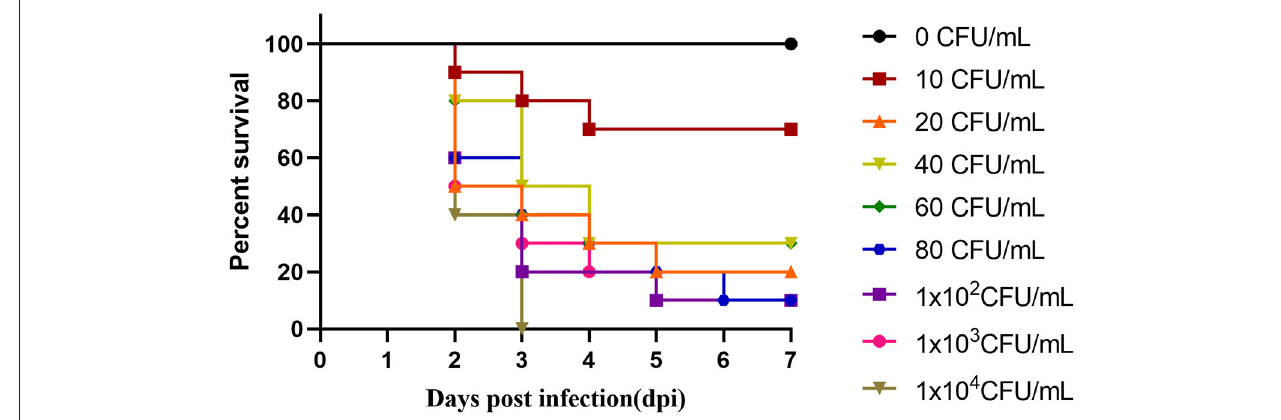
FIGURE 2 | Survival curves of Muscovy duck in pathogenicity test. The horizontal axis represents days after infection, the vertical axis represents survival, and the different curves represent different dose groups.